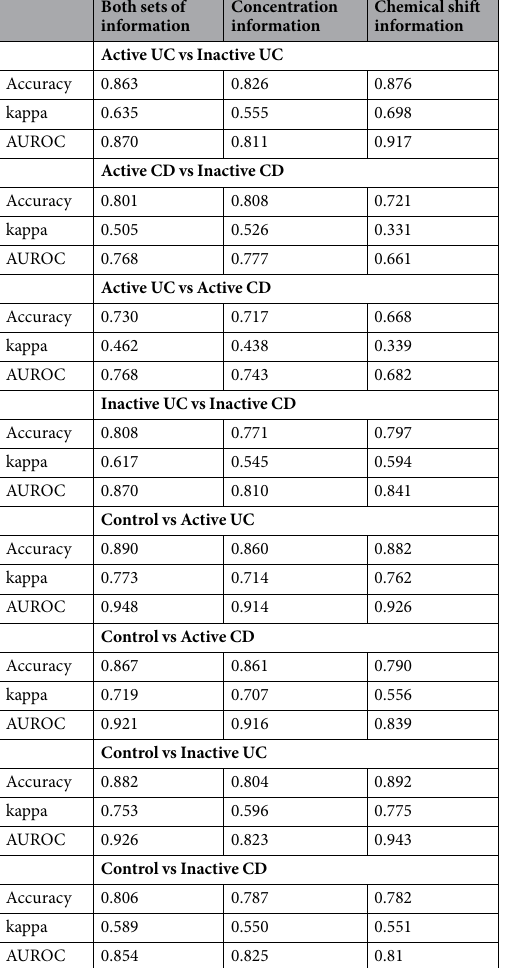
Table 2. Adding chemical shift information to concentration information improved the classification between the five different kinds of sample in the MTBLS237 dataset. Several quality indicators of the models generated with only concentration information, only chemical shift information and both sources of information are shown for the eight comparisons between the five subclasses (control, active UC, inactive UC, active CD, inactive CD).